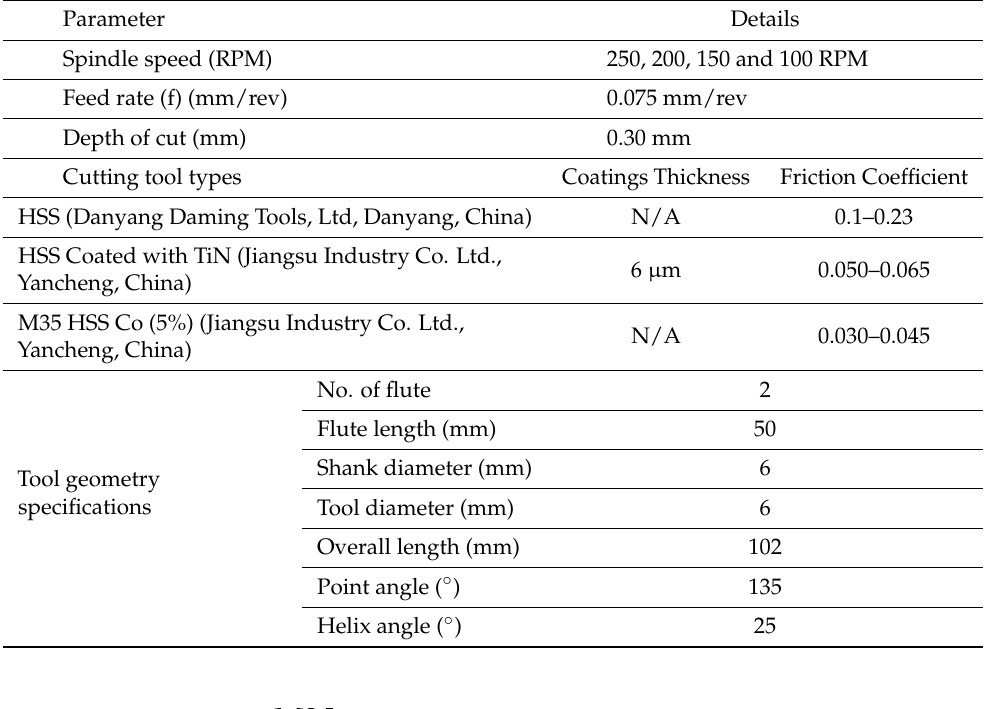
Table 2. Parameter details in drilling fly ash geopolymer.